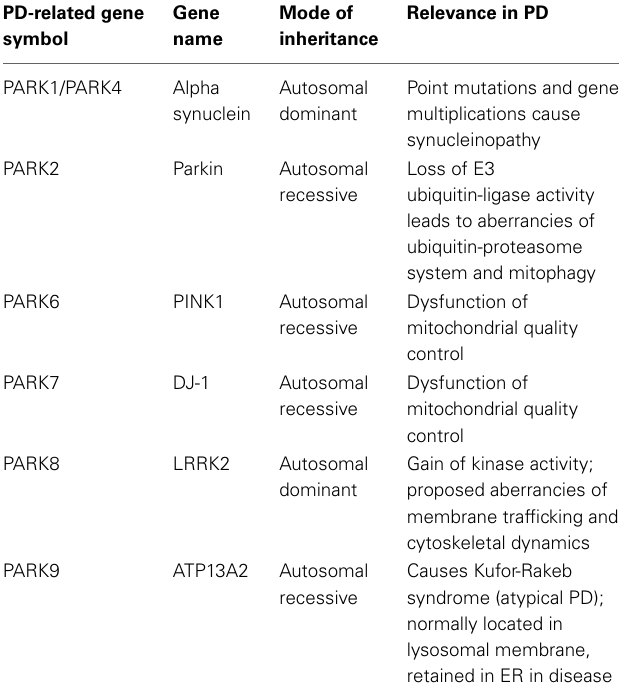
Table 1 | PD-related genes.